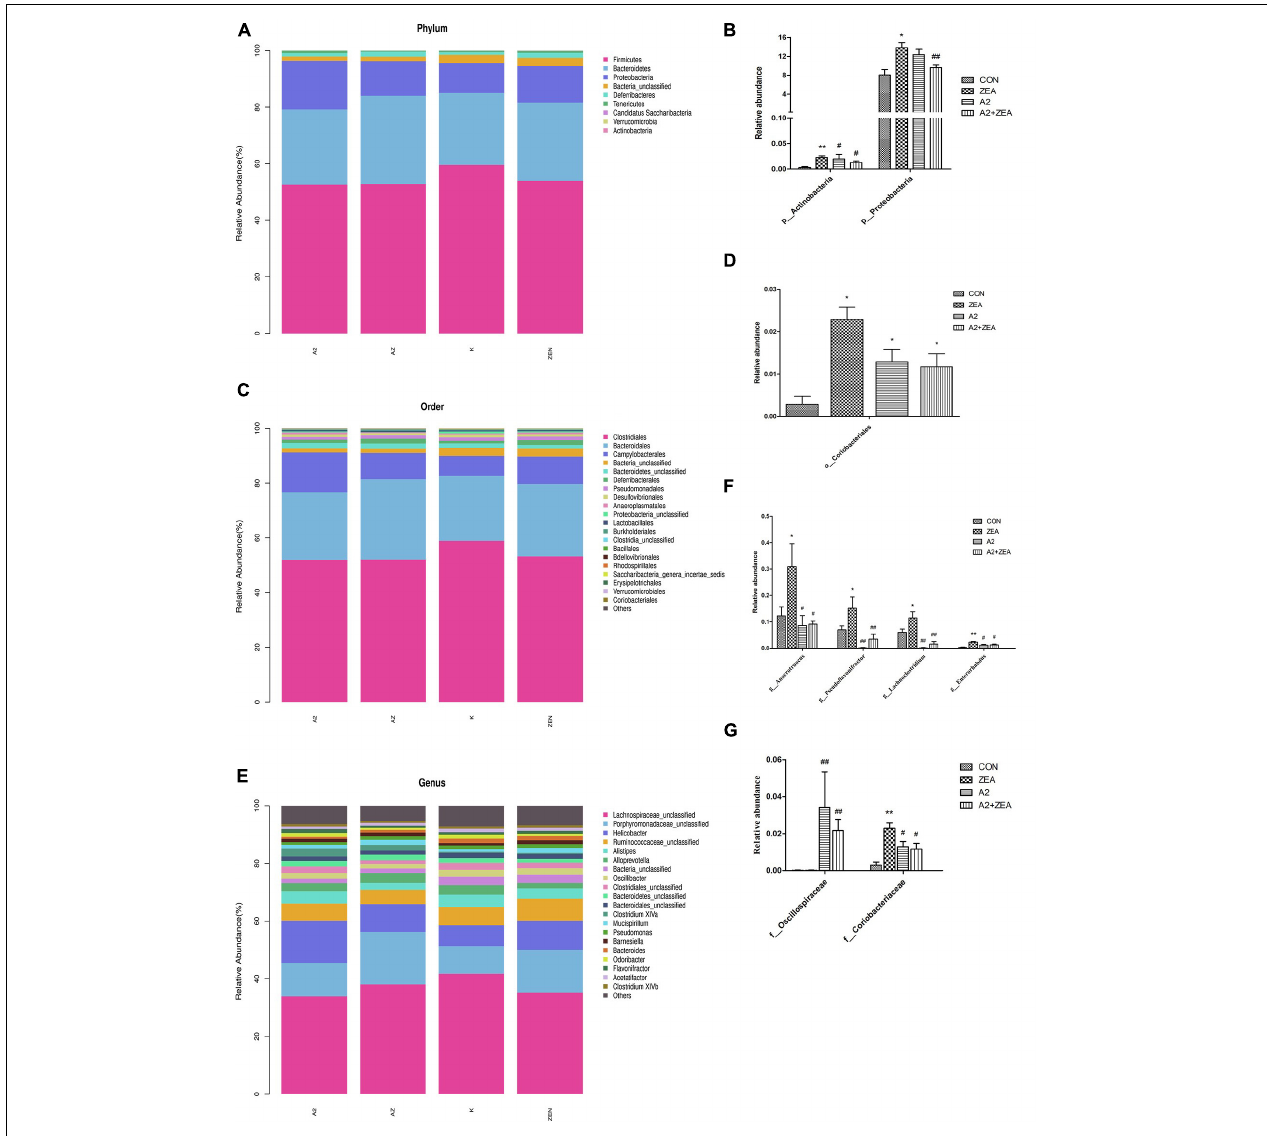
FIGURE 8 | Annotation and classification of phyla (A) , order (C) and genus (E) . The ordinate represents the relative abundance of species at each classification level, and the abscissa denotes each classification level. Histograms of species showing significant differences at each rank include phyla (B) , order (D) , family (G) , and genus (F) . The abscissa marks the microbial community, and the ordinate marks the abundance of the community. "*" means a significant difference compared with the CON group ( P < 0.05), and "**" means an extremely significant difference compared with the CON group ( P < 0.01). "#" means a significant difference compared with ZEA ( P < 0.05), "##" means an extremely significant difference compared with ZEA ( P <